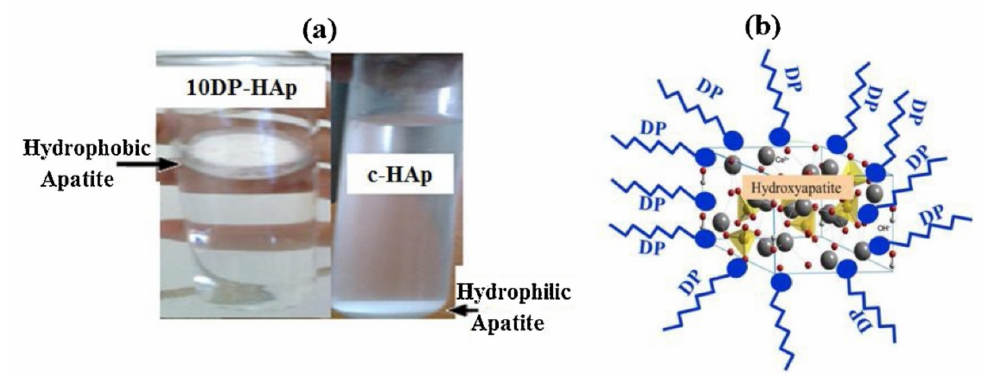
Figure 2. ( a ) Picture showing the transformation of the surface properties of the material, going from a totally hydrophilic character for the pure c-HAp (right) to a hydrophobic surface-modified behavior for the 10 DP-HAp hybrid material (left). ( b ) Schematic showing the hydrophobic surface modification of the Hap nanoparticles with a DP coupling